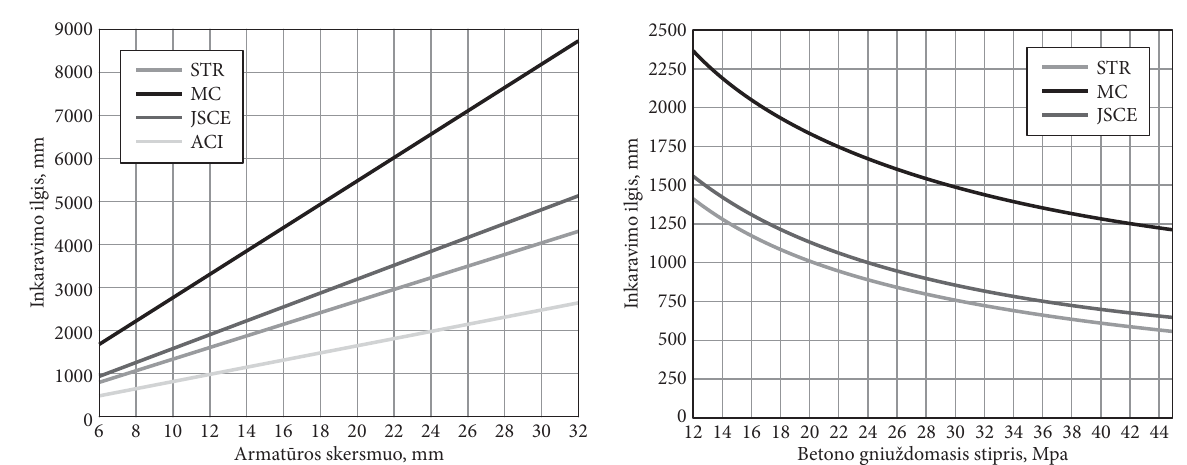
6 pav. Anglies pluošto armatūros inkaravimo ilgio l kintant betono gniuždomajam stipriui Fig. 6. Eff ect of concrete compression strength on carbon fi ber reinforced polymer bars achorage length l